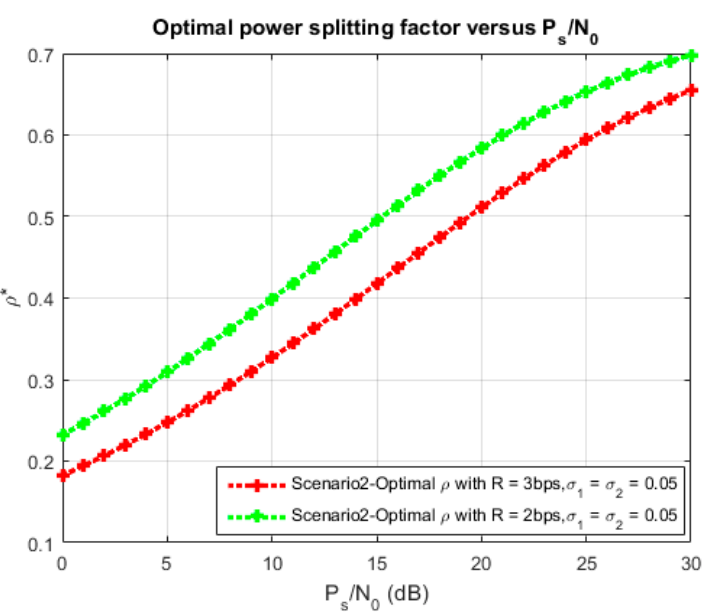
Figure 11. The optimal PS factor versus P s / N 0 for the first case.